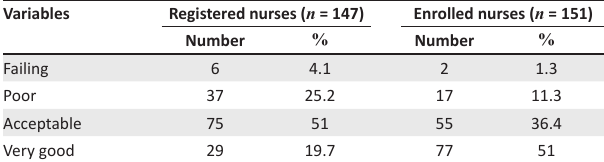
TABLE 4: Please give your unit an overall grade on patient safety. Variables